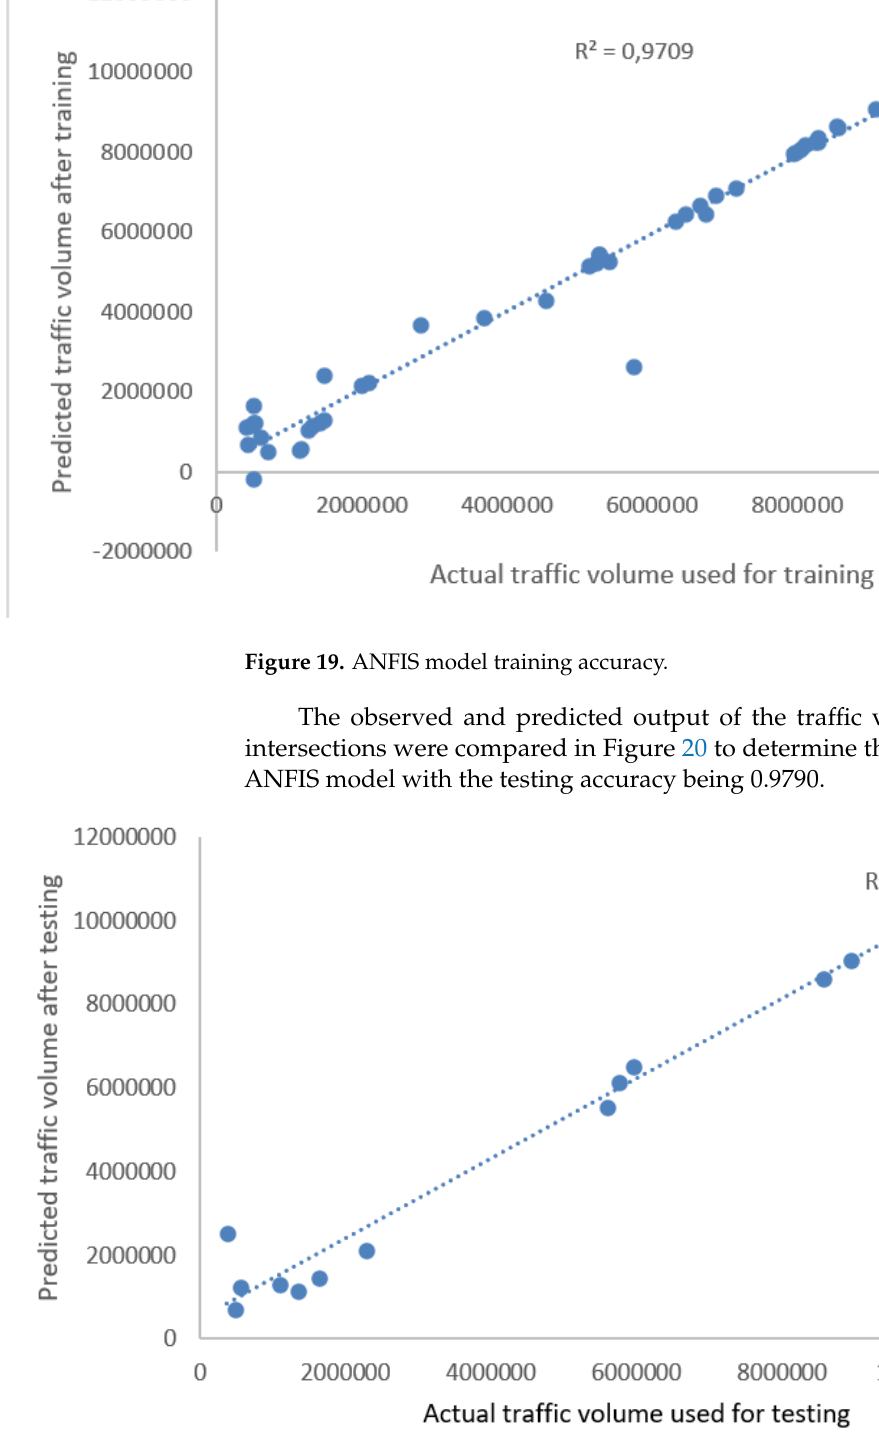
Figure 20. ANFIS model testingraining accuracy.